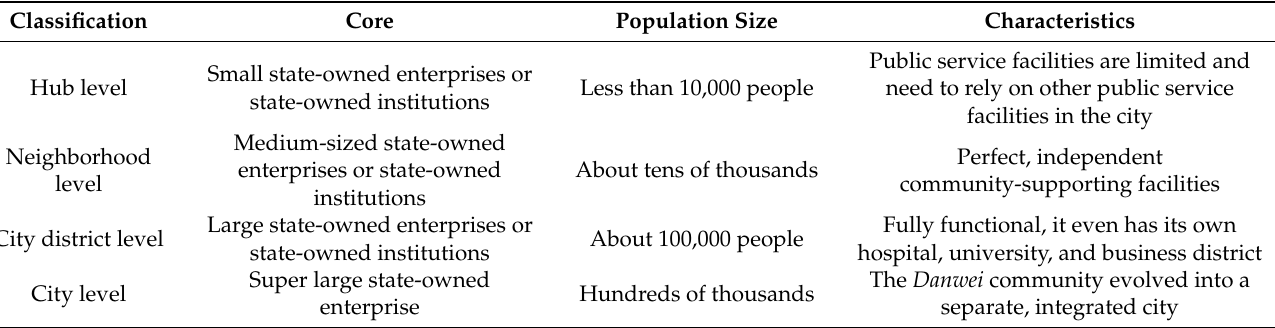
Figure 2. Distribution of the danwei communities in built-up areas of a Chinese city during the period (adapted from [19]). Table 2. Size classification of the danwei